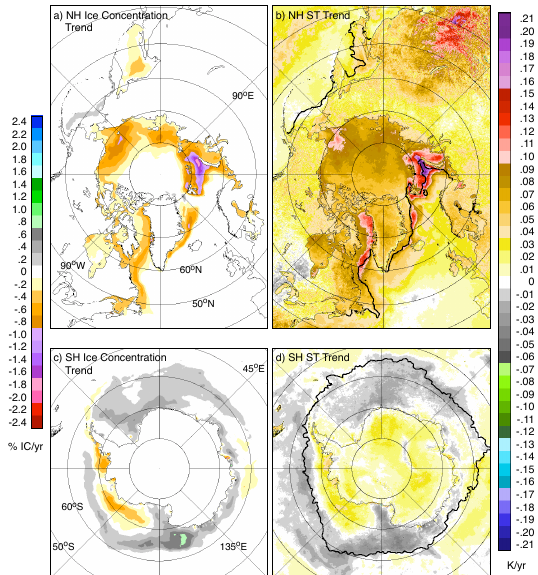
Figure 10. Trends in surface temperature in the Arctic and the